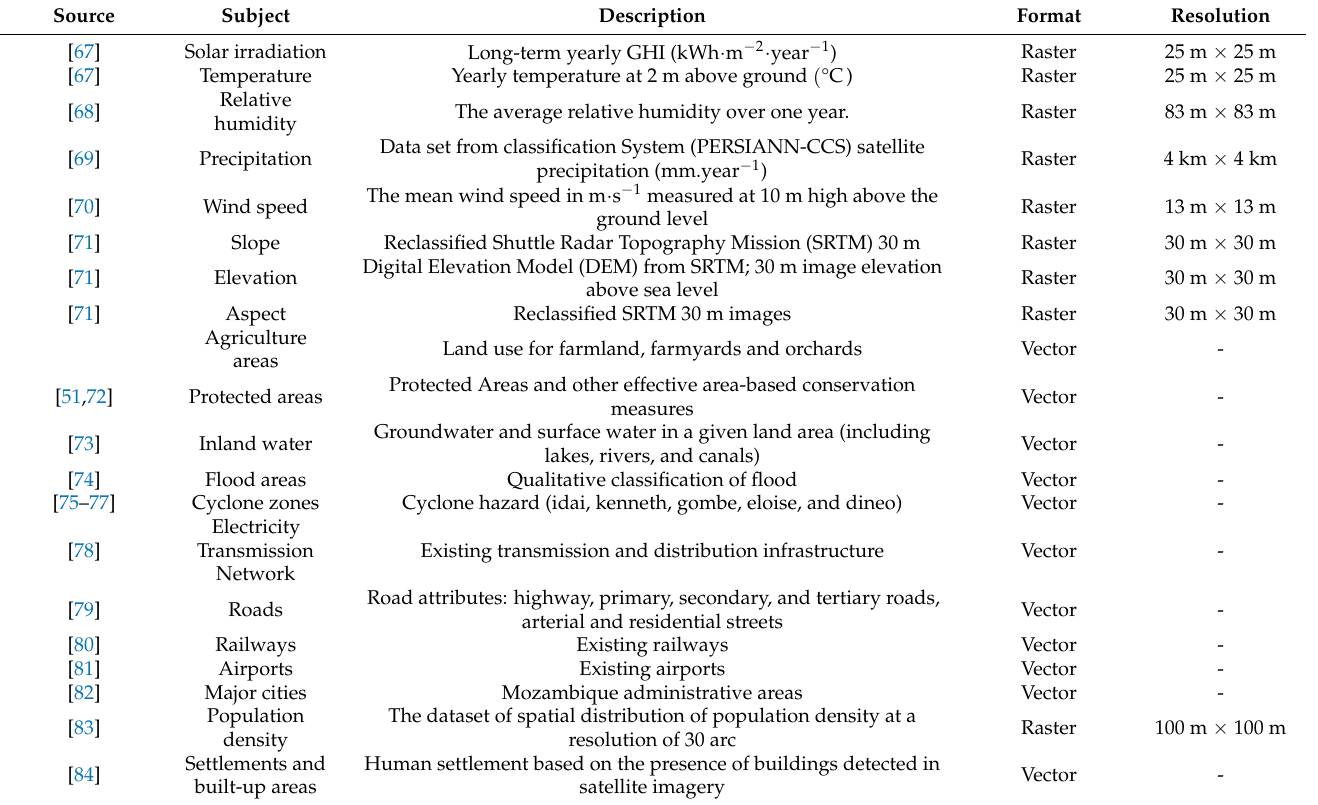
Table 4. Collected data sets to identify suitable sites for the installation of solar PV